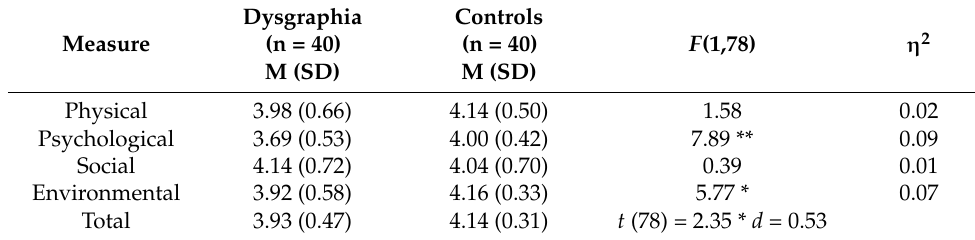
Table 5. Comparison between groups in QOL measures.